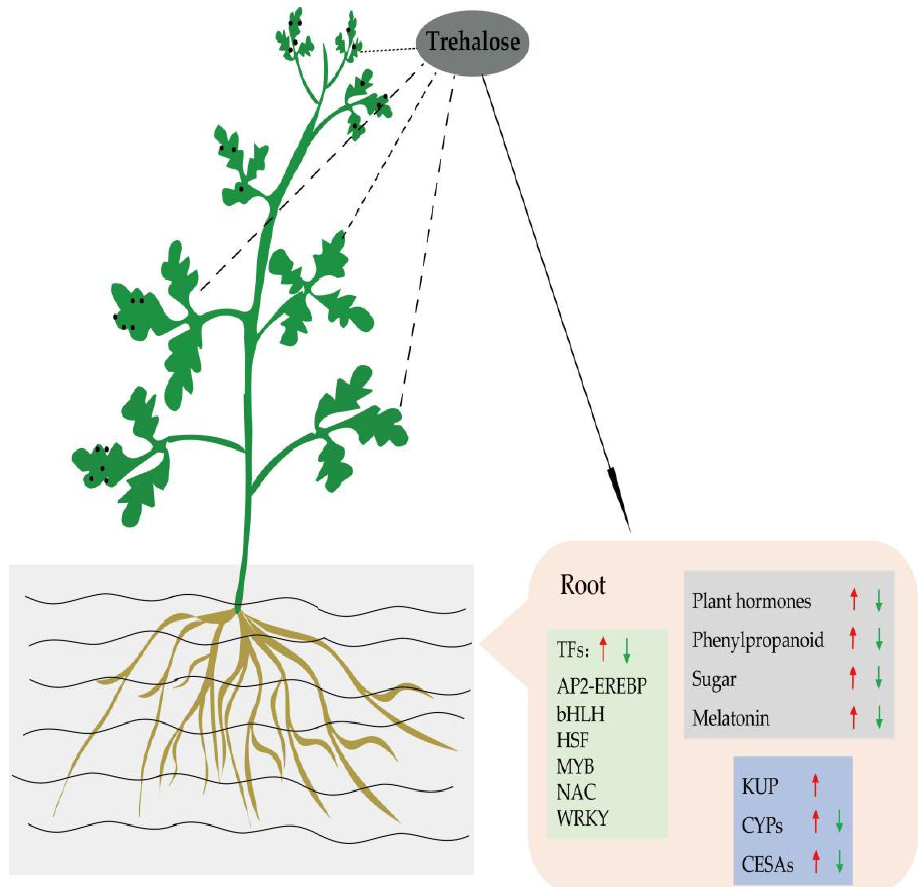
Figure 12. Hypothesized mechanism of exogenous trehalose enhancing salt tolerance of water- melon seedlings.